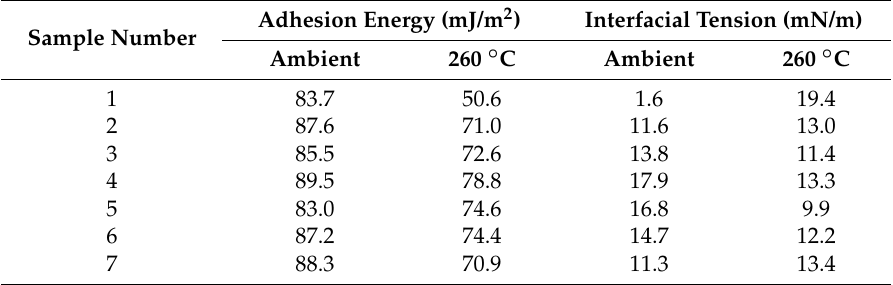
Table 7. Adhesion energy and interfacial tension for LEXAN™ HF1110 polycarbonate. Sample Number